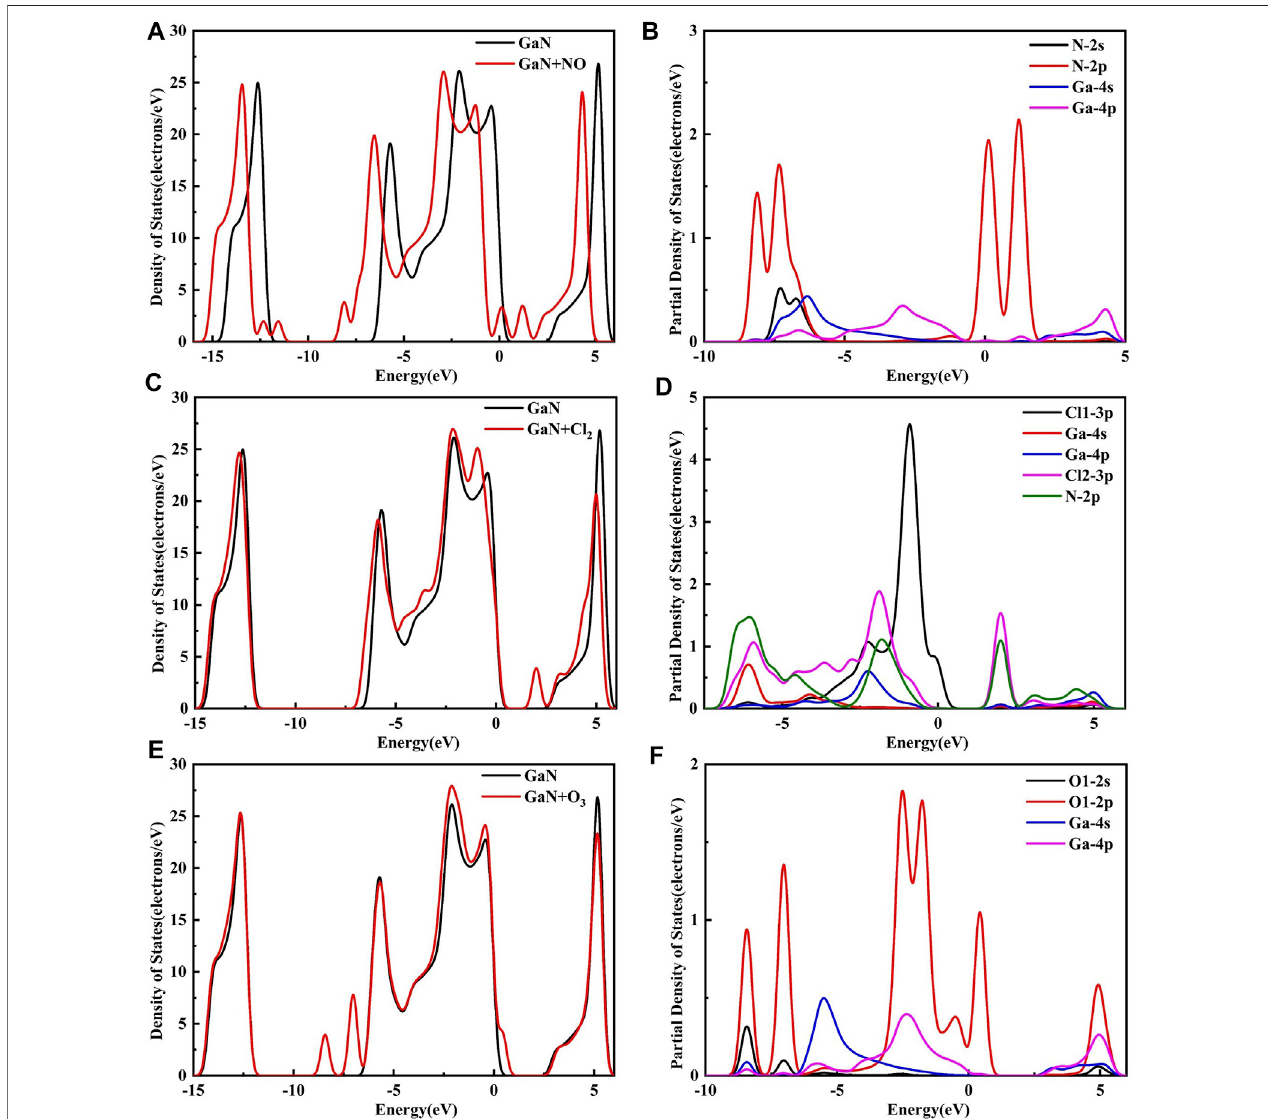
FIGURE 8 | DOS for (A) NO, (C) Cl 2 , and (E) O 3 on the GaN surface and PDOS for (B) NO, (D) Cl 2 , and (F) O 3 on the GaN surface.